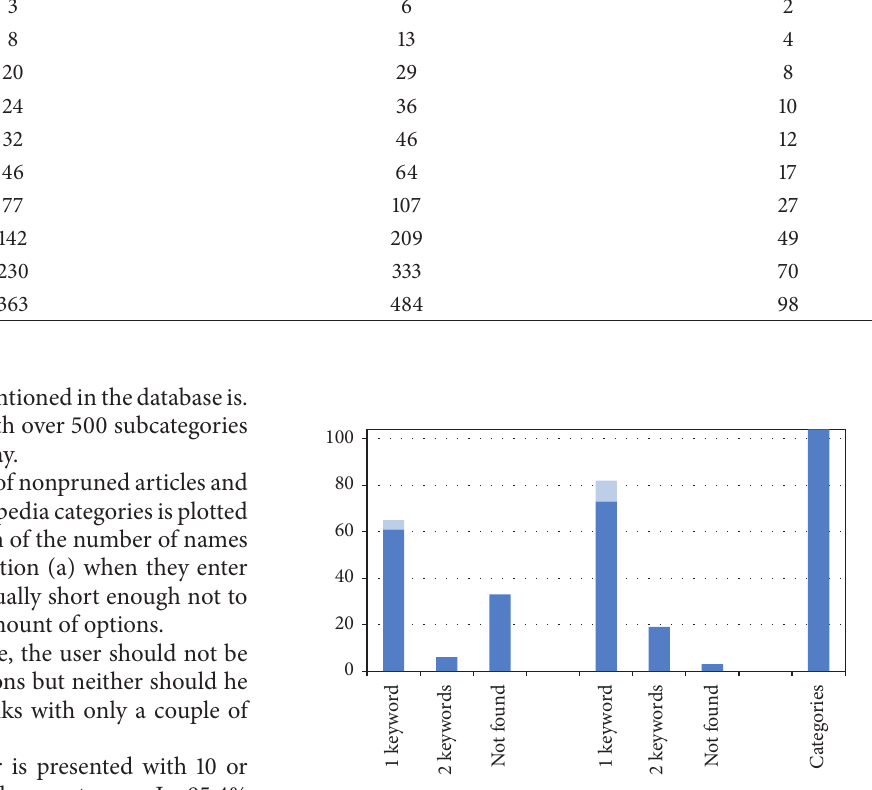
Figure 7: Number of named entities, out of 104, that were found using single related keyword queries and number that could not be found using single related keyword queries but was found using queries that contain 2 related keywords using the database’s text search engine (left) and using Google (center). All named entities can be found clicking through the pruned category structure (right). Named entities found through queries with keywords that relate